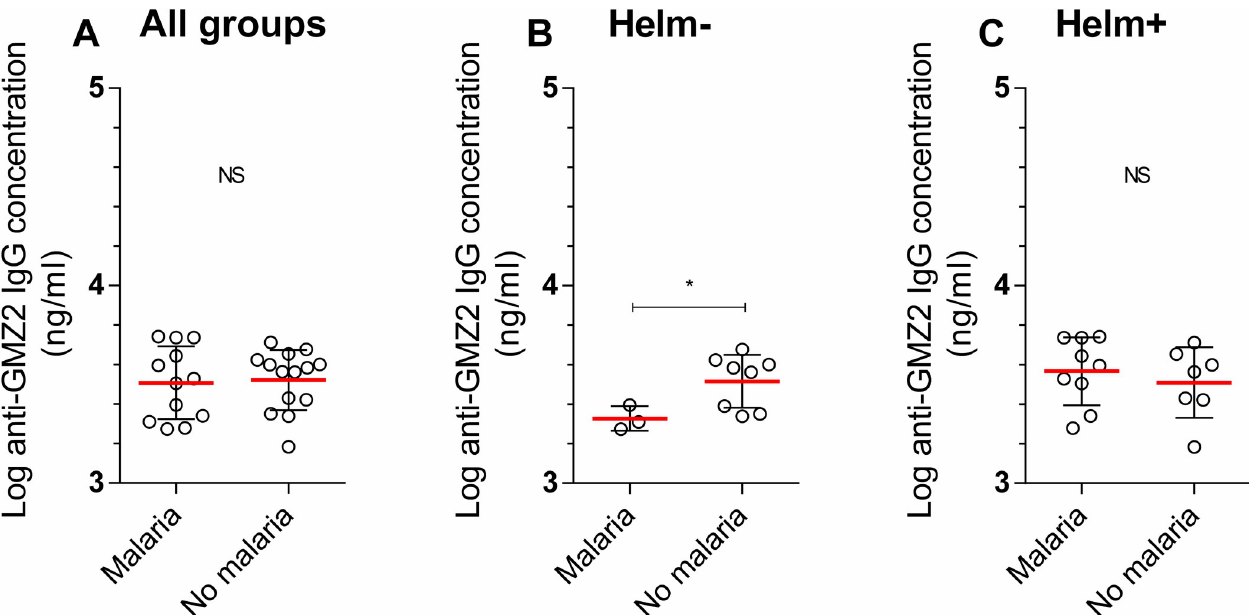
Fig 5. Anti-GMZ2 IgG concentration and CHMI outcome groups according to helminth status Comparison of vaccine-specific total IgG concentration at D84 between those having clinical malaria (monotone increase of parasitemia with symptoms) and those without clinical malaria (low oscillating parasitemia and no symptoms (control) and those with no parasitemia and no symptoms (protected)) after the CHMI was performed in all participants (n = 12 vs 14, 5A), in helminth uninfected (n = 3 vs 8, 5B), and infected (n = 9 vs 7, 5C) participants. The comparison was done by multivariate linear regression using baseline vaccine-specific total IgG concentration as variable of adjustment. Statistical significance was set for p value below 0.05. � p < 0.05 NS = Non-significant.